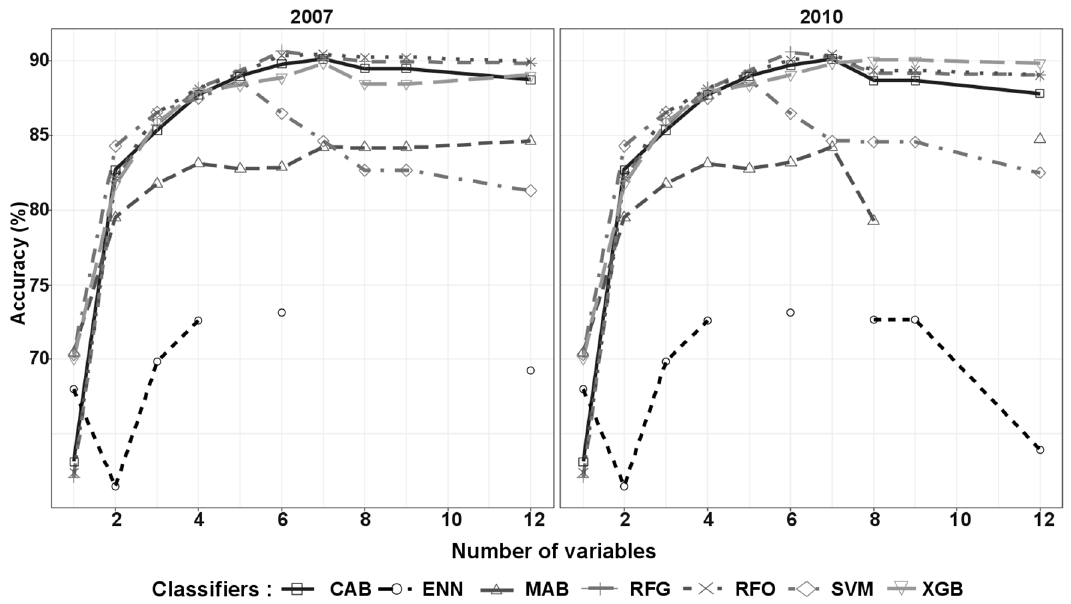
Figure 9. Consecutive accuracy of a different number of variables ordered by variable importance generated by seven classifiers based on RF.